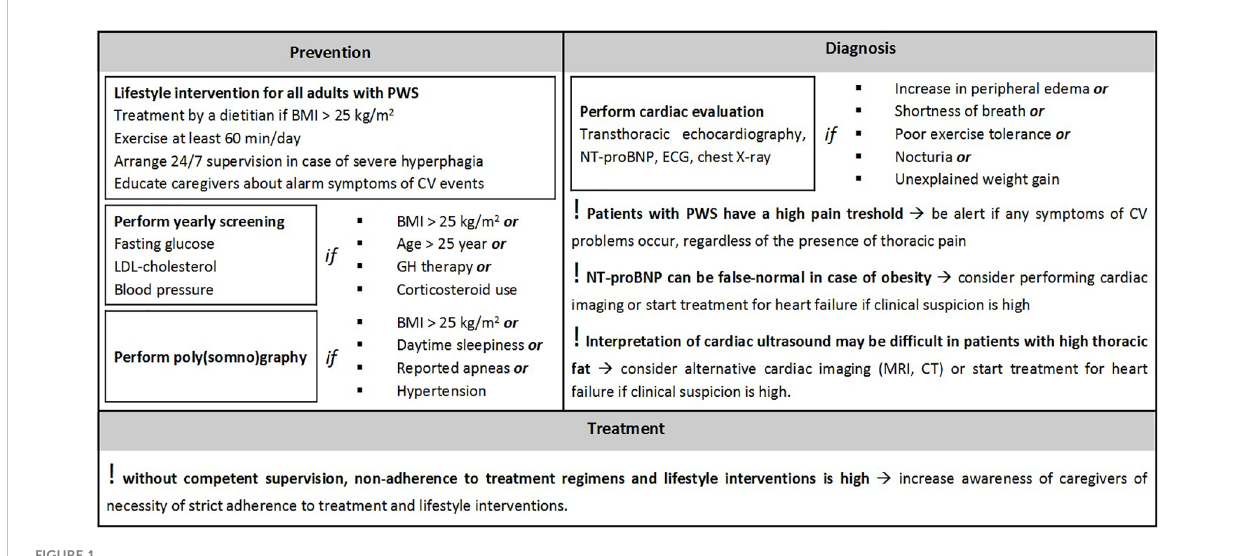
FIGURE 1 Recommendations for prevention, diagnosis and treatment of cardiovascular events in adults with Prader-Willi syndrome. Abbreviations: 24 hours a day, 7 days a week (24/7), body mass index (BMI), computed tomography (CT), cardiovascular (CV), electrocardiogram (ECG), growth hormone (GH), low-density lipoprotein (LDL), minutes (min), magnetic resonance imaging (MRI), Prader-Willi syndrome (PWS). These recommendations only consider factors related to cardiovascular disease. For the full screening protocol for prevention, see Pellikaan et al. (17).